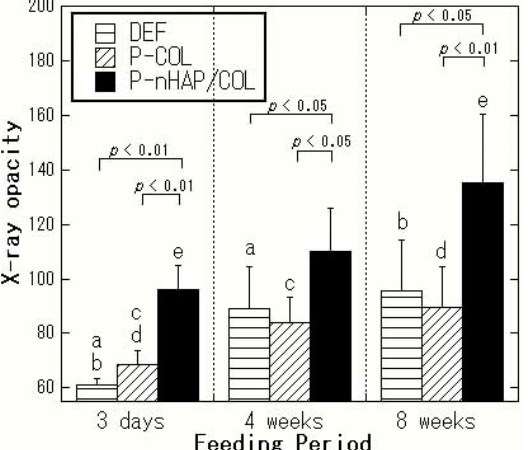
Figure 5. Graphs of X-ray opacity in the defects with and without implant materials (DEF, P-COL, and P-nHAP/COL) ( n = 6). Note: Pairs indicated with the same letter were significantly different. Note: a and b, p < 0.01; c–e, p <